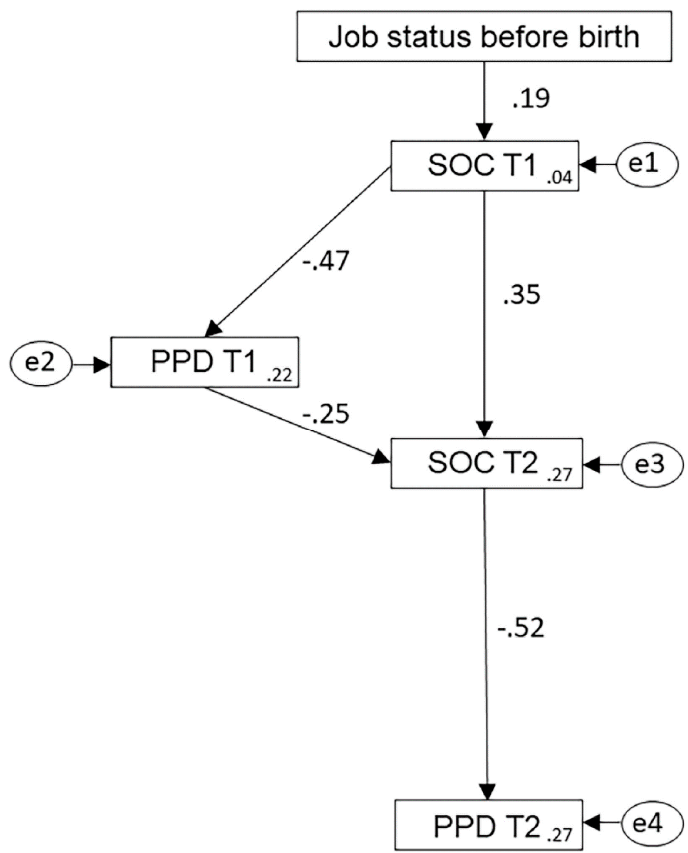
Figure 1. Structural equation model of the relationship between job status prior to the birth, mothers’ sense of coherence (SOC) and postpartum depression (PPD) immediately after the birth (T1) and nine months later (T2). The standardized coefficient for each effect is given beside the corresponding pathway arrow.